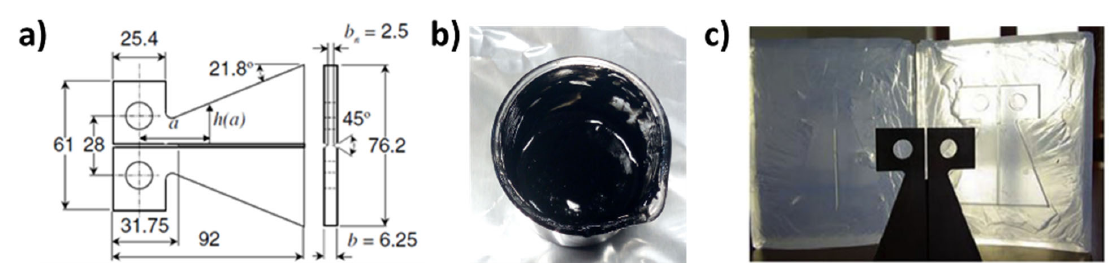
Figure 2. ( a ) TDCB geometry and dimensions (mm); ( b ) prepared mixture; ( c ) molded